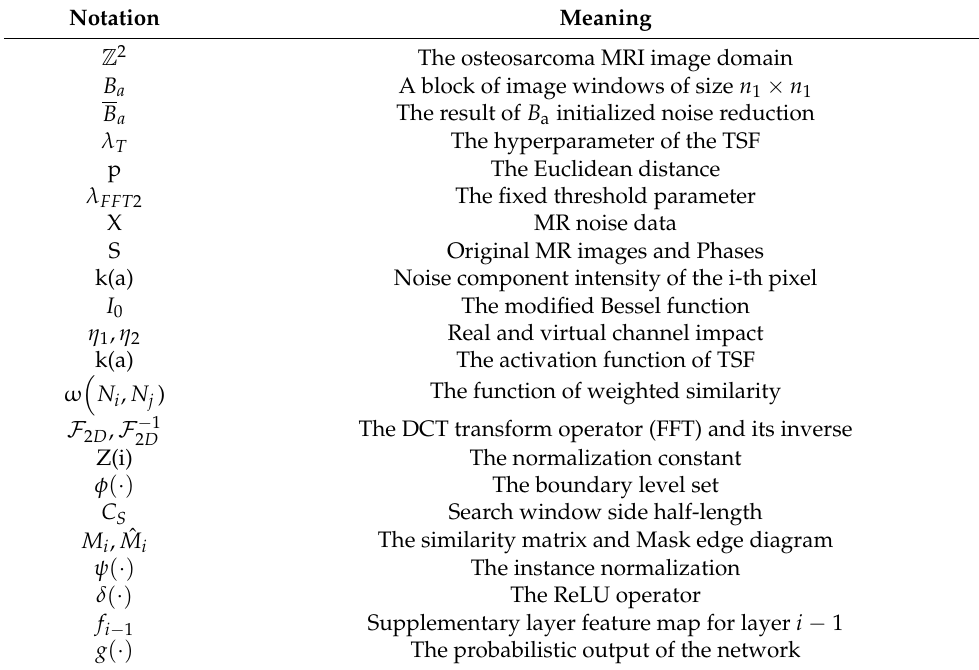
Table 1. Main mathematical notations and their